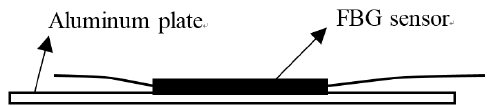
Figure 7. Schematic diagram when bonding the sensors on the aluminum plate.